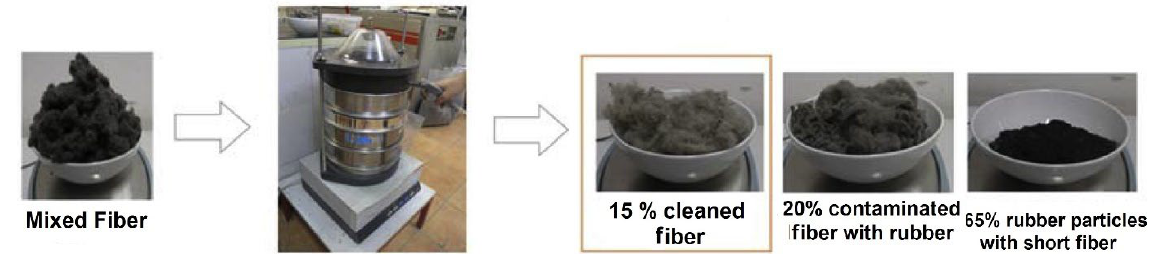
Figure 9. By-products obtained after cleaning mixed fiber